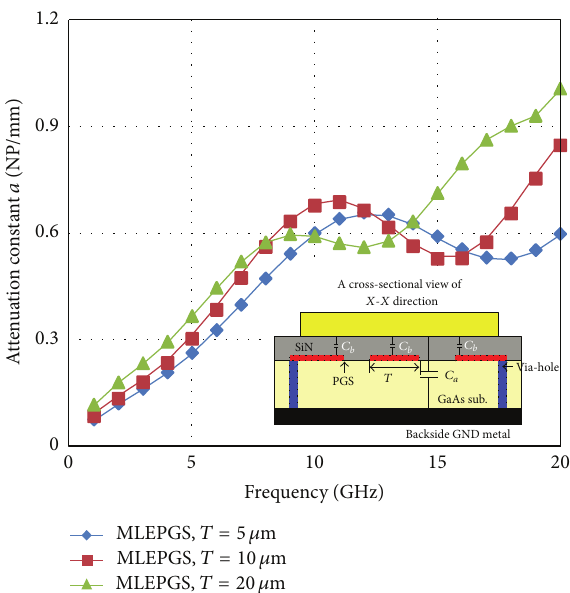
Figure 5: Measured propagation constant of the MLEPGS.